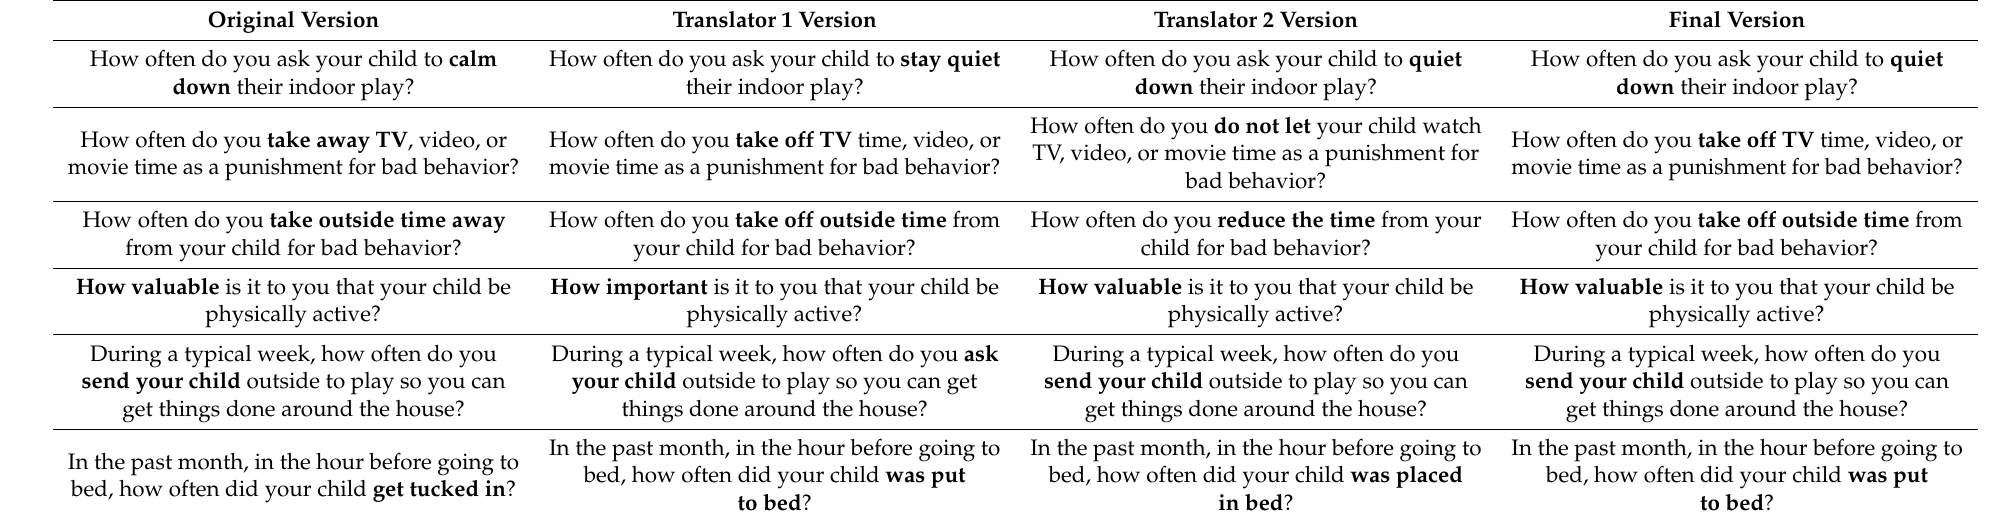
Table 2. Discrepancies in the translations of the measurement tools in English to